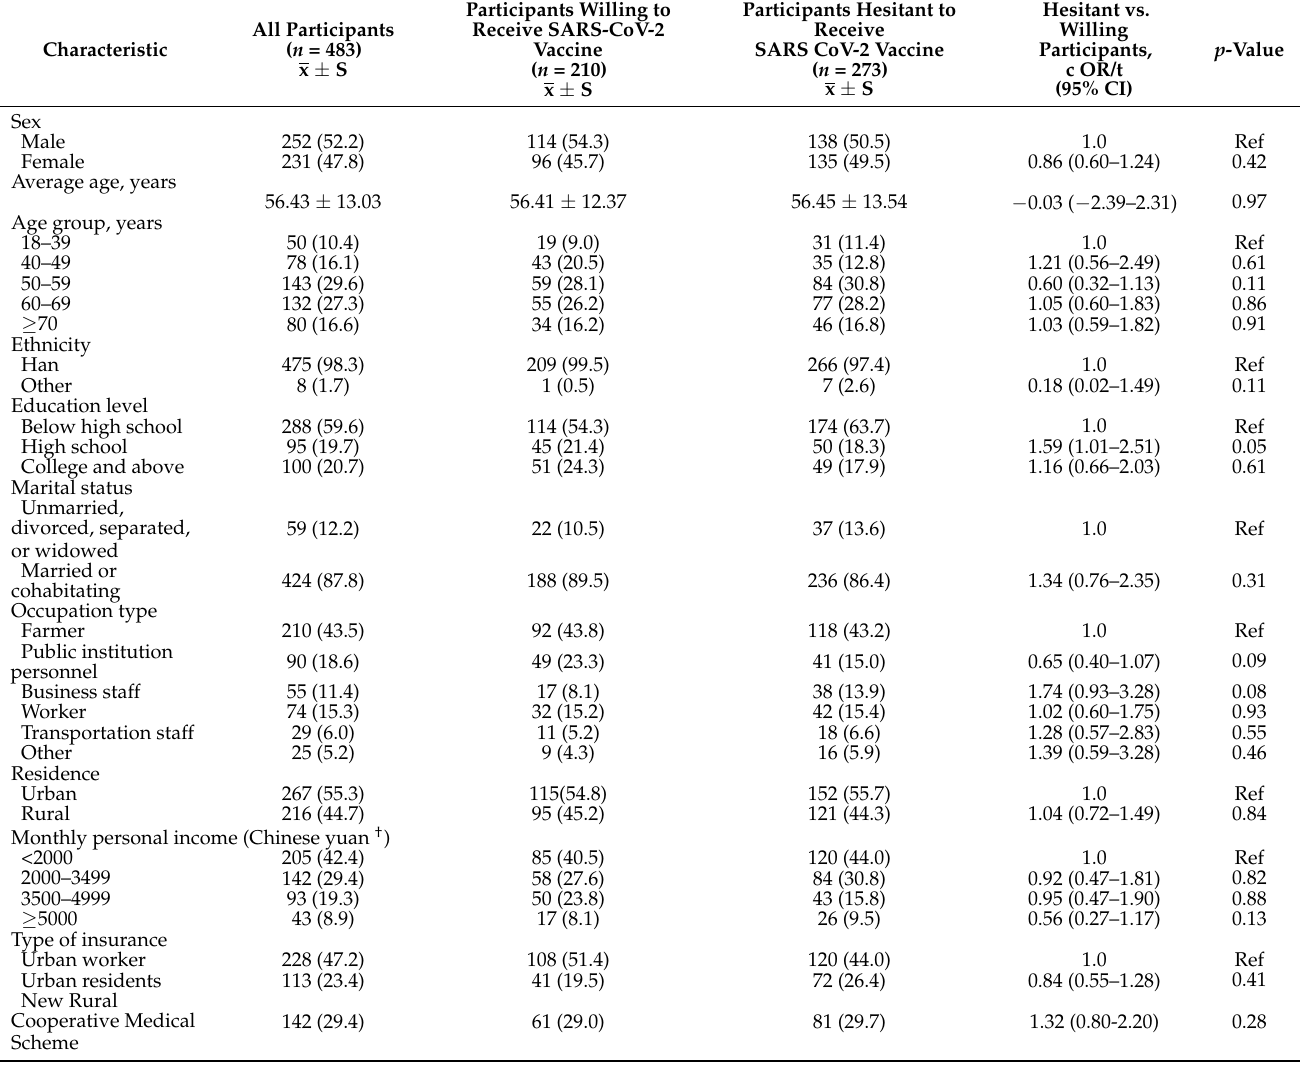
Table 1. Sociodemographic characteristics of the study population. ( n = 483).